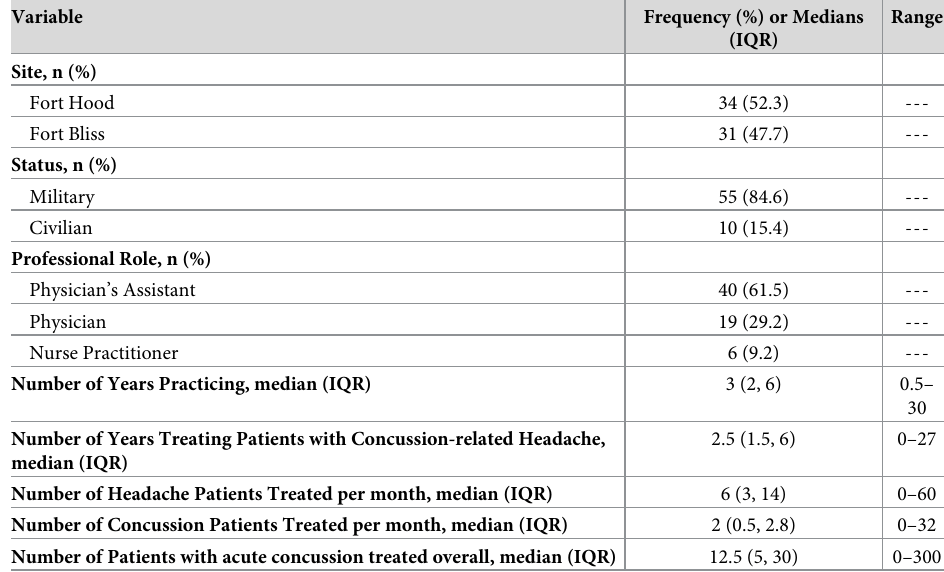
Table 1. Provider characteristics and experience treating concussion and concussion-related headache among Ser- vice members (N =